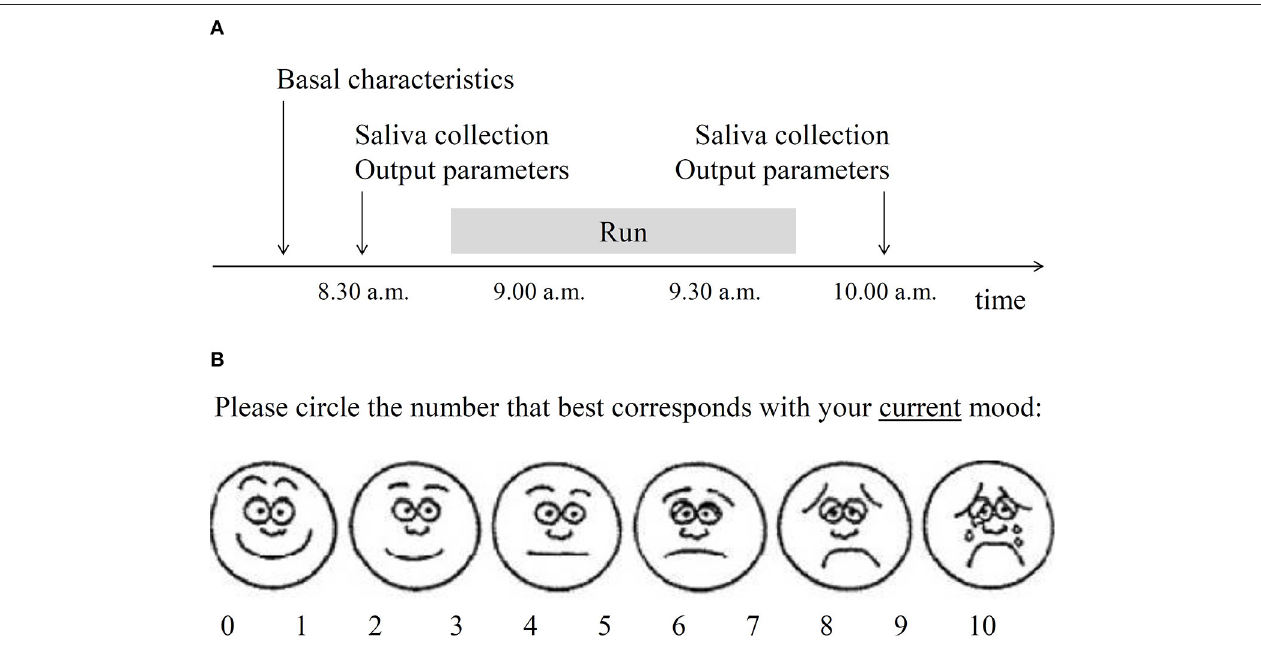
FIGURE 1 | Selected methodological details of the study. (A) Timeline of the study. Basal characteristics included sociodemographic and physical parameters, substance use history, depressive, and anxiety symptoms over 2 weeks and oropharyngeal factors relevant to saliva collection. Saliva was collected to assess